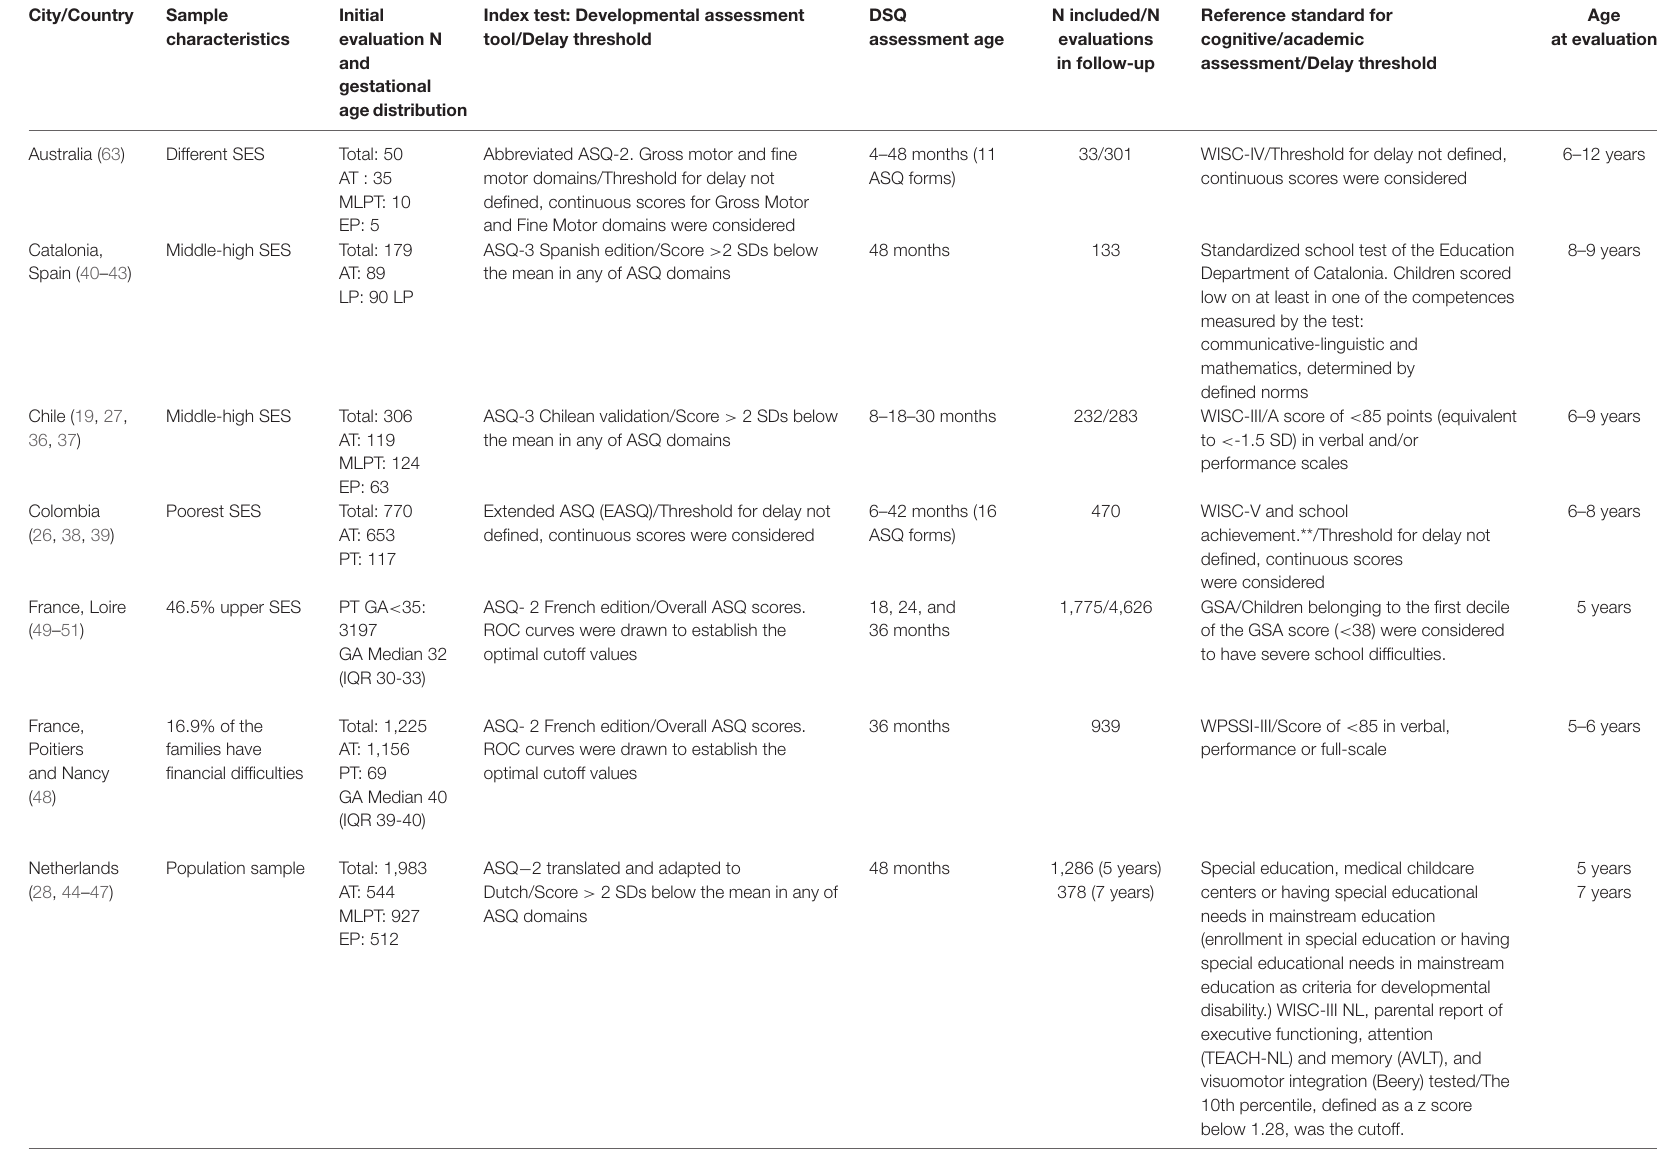
TABLE 1 | Qualitative summary of included